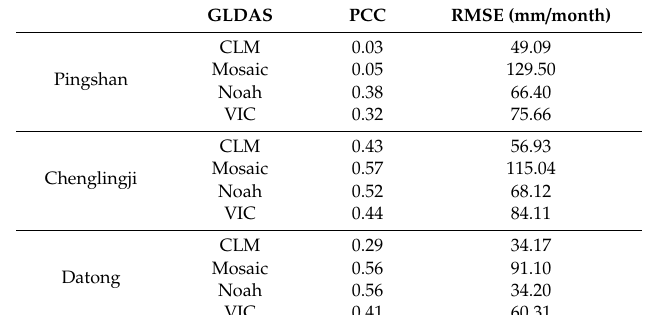
Table 5. Statistical comparison between the remotely sensed GRACE (CSR) and the GLDAS-modeled terrestrial water storage datasets at the three selected stations along the upper, middle, and lower reaches of the Yangtze River basin.